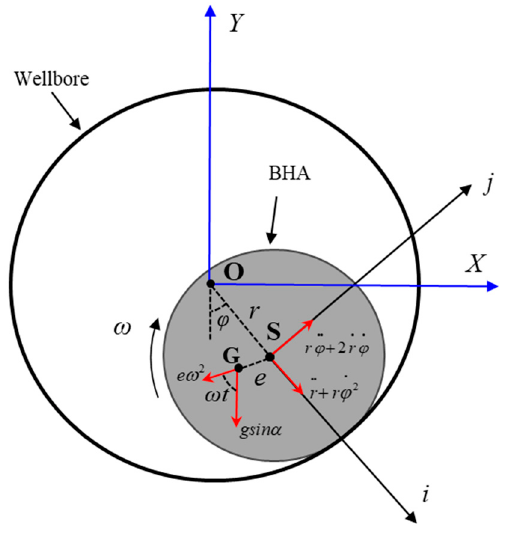
Figure 2. Point G is the mass center and point S is the geometric center.